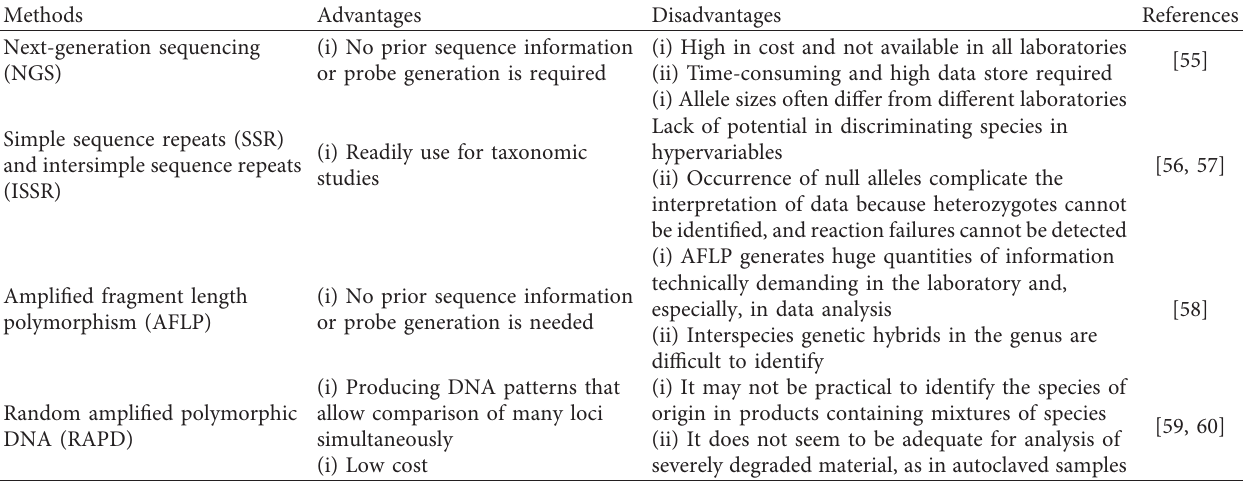
Table 2: Available genetic barcoding methods for the prevention of